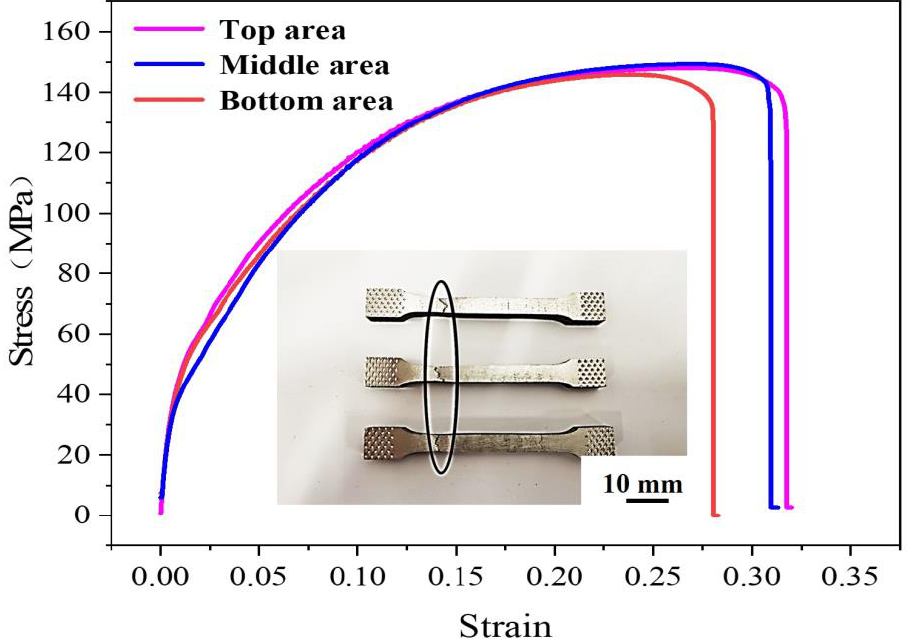
Figure 7. Stress-strain curves of 4043 aluminum alloy formed parts at different heights in the horizontal direction. Table 3. Tensile results of 4043 aluminum alloy formed parts at different heights in the horizontal 319 direction.